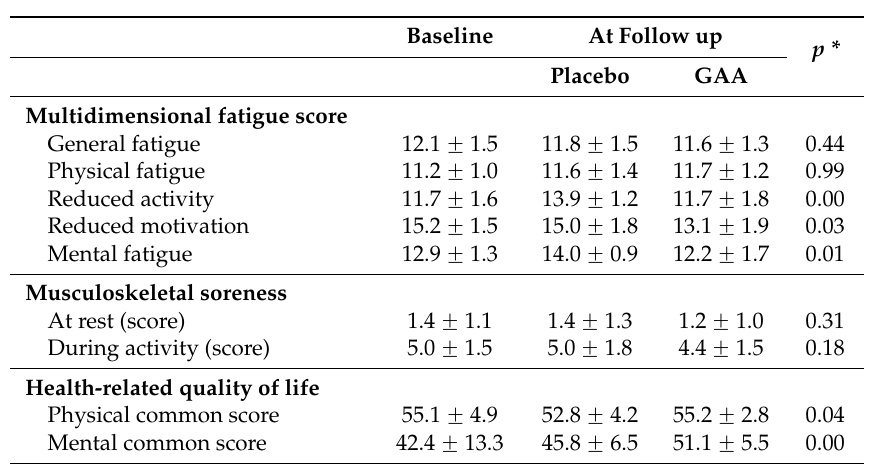
Table 1. Changes in multidimensional fatigue scores, health-related quality of life, and musculoskeletal soreness from baseline to three months. Values are mean ˘ SD. GAA- guanidinoacetic